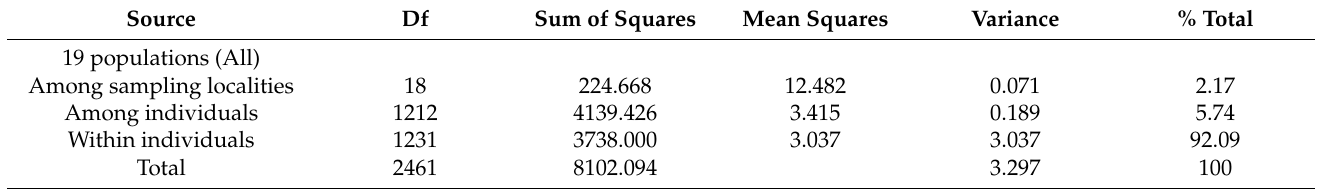
Table 7. Analysis of molecular variance (AMOVA) among different black sea bream